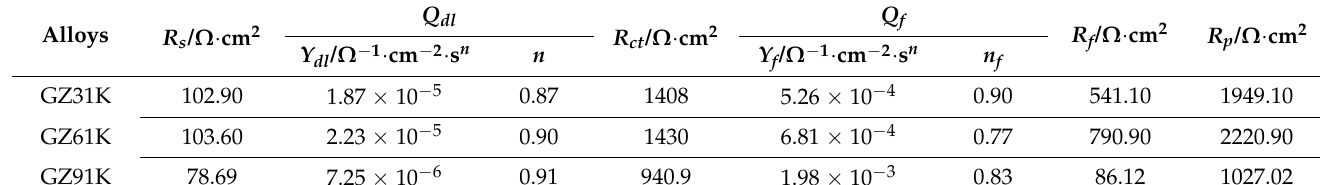
Table 4. Fitting results of electrochemical parameters obtained from EIS.